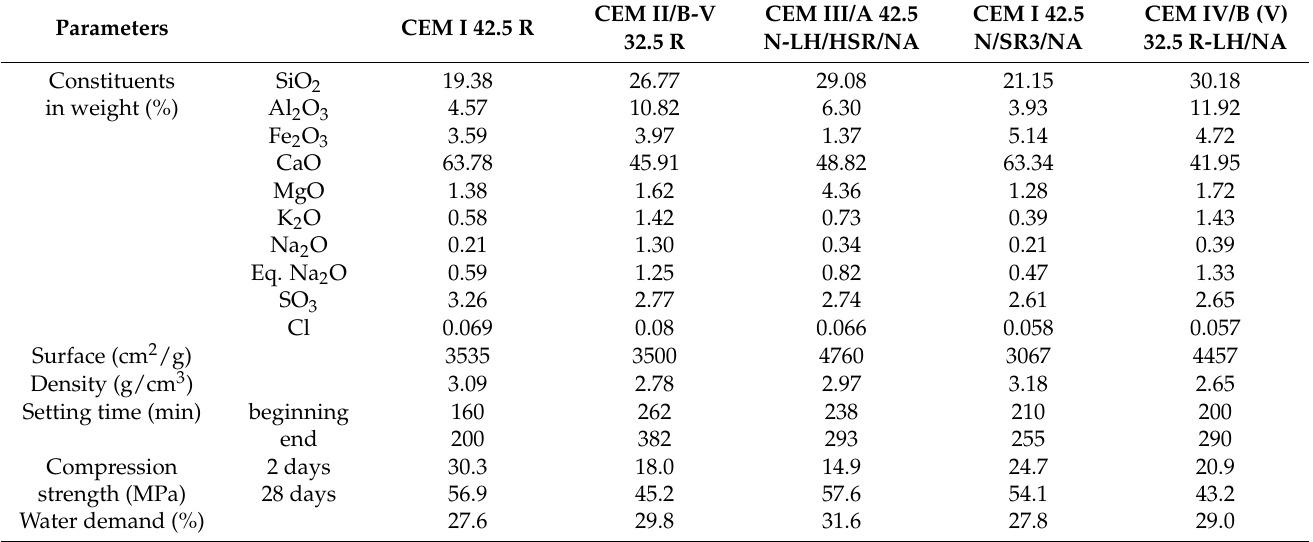
Table 1. Chemical composition and selected properties of cements according to the producer’s specification. The denotations used in the table: CEM I—Portland cement; CEM II—multi-component Portland cement; CEM III—blast furnace cement; CEM IV—pozzolanic cement; for CEM II/B,